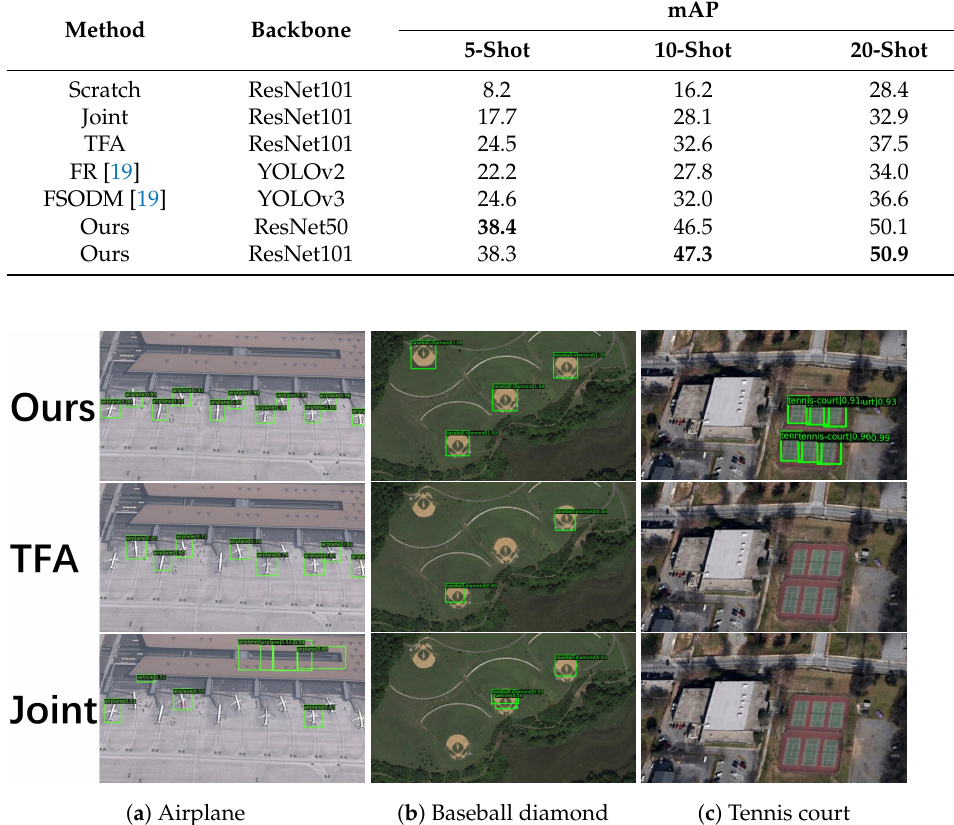
Figure 11. Results of 10-shot models on novel classes in the NWPU VHR-10 dataset. (From top to bottom: Ours, TFA and Joint).